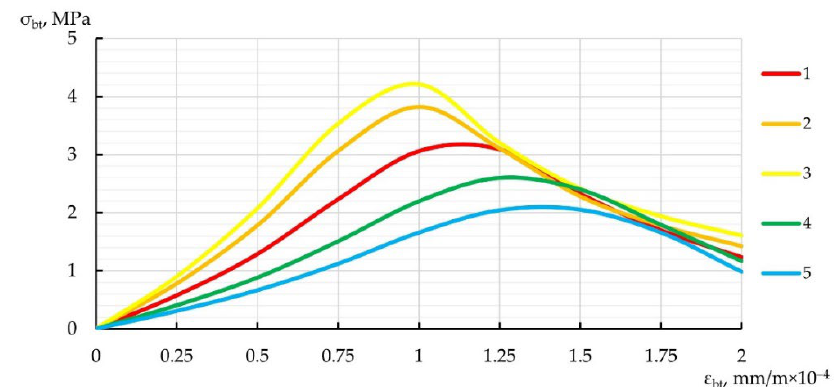
Figure 13. Tensile stress-strain diagram.